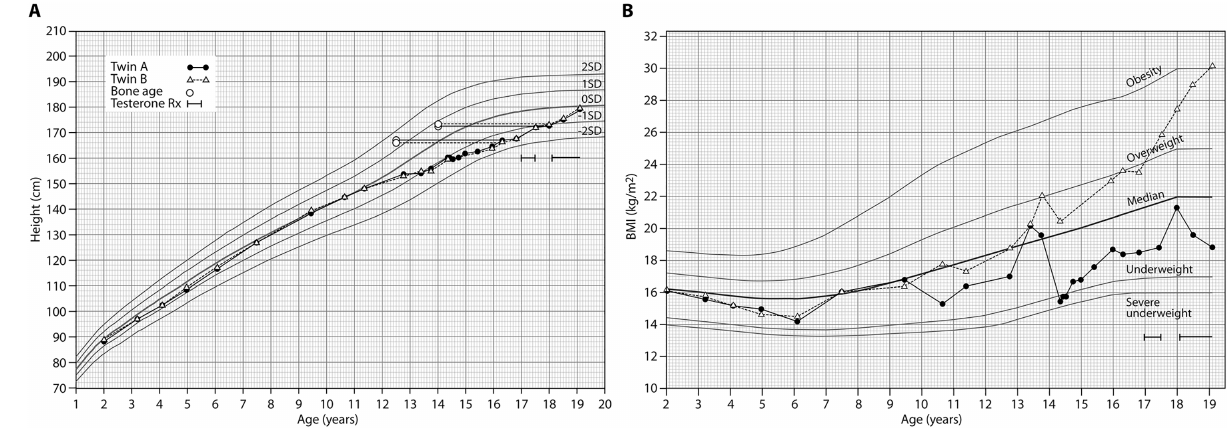
Fig 1. Growth charts of monozygotic twin brothers who presented with stalled puberty due to biallelic mutations in GNRHR (c.317A > Gp.(Gln106Arg) and c.785G > Ap.(Arg262Gln)). A. Longitudinal growth of the brothers was practicallyidentical. Note the absenceof pubertalgrowth spurt. B. The brothers were discordant for weight. The reference ranges for body mass index (BMI) were modified from [20].